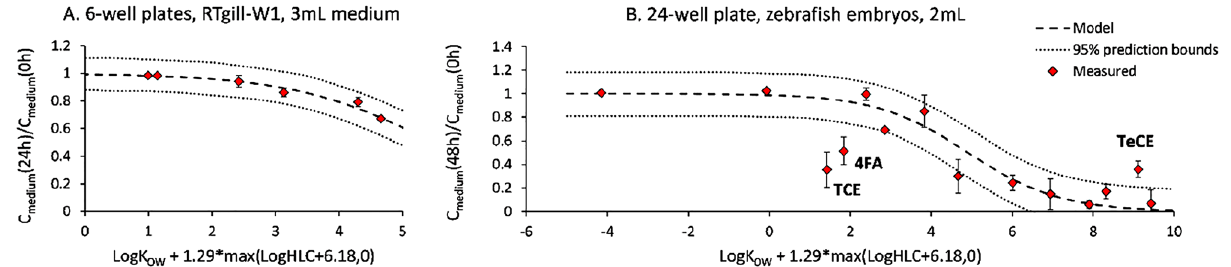
Figure 5. Model extrapolation to other systems covered with an adhesive foil. ( A ) Extrapolation to 6-well plates with RTgill-W1 cell line and medium containing 5% FBS. ( B ) Extrapolation to FET system 12 . Measured ratio of the chemical concentration in the medium at the end and the beginning of the experiment is plotted versus chemical log K OW and logHLC. Abbreviations stand for chemicals of which concentrations were not within the 95% prediction bounds: TCE is 2,2,2-trichloroethanol, 4FA is 4-fluoroaniline, and TeCE is